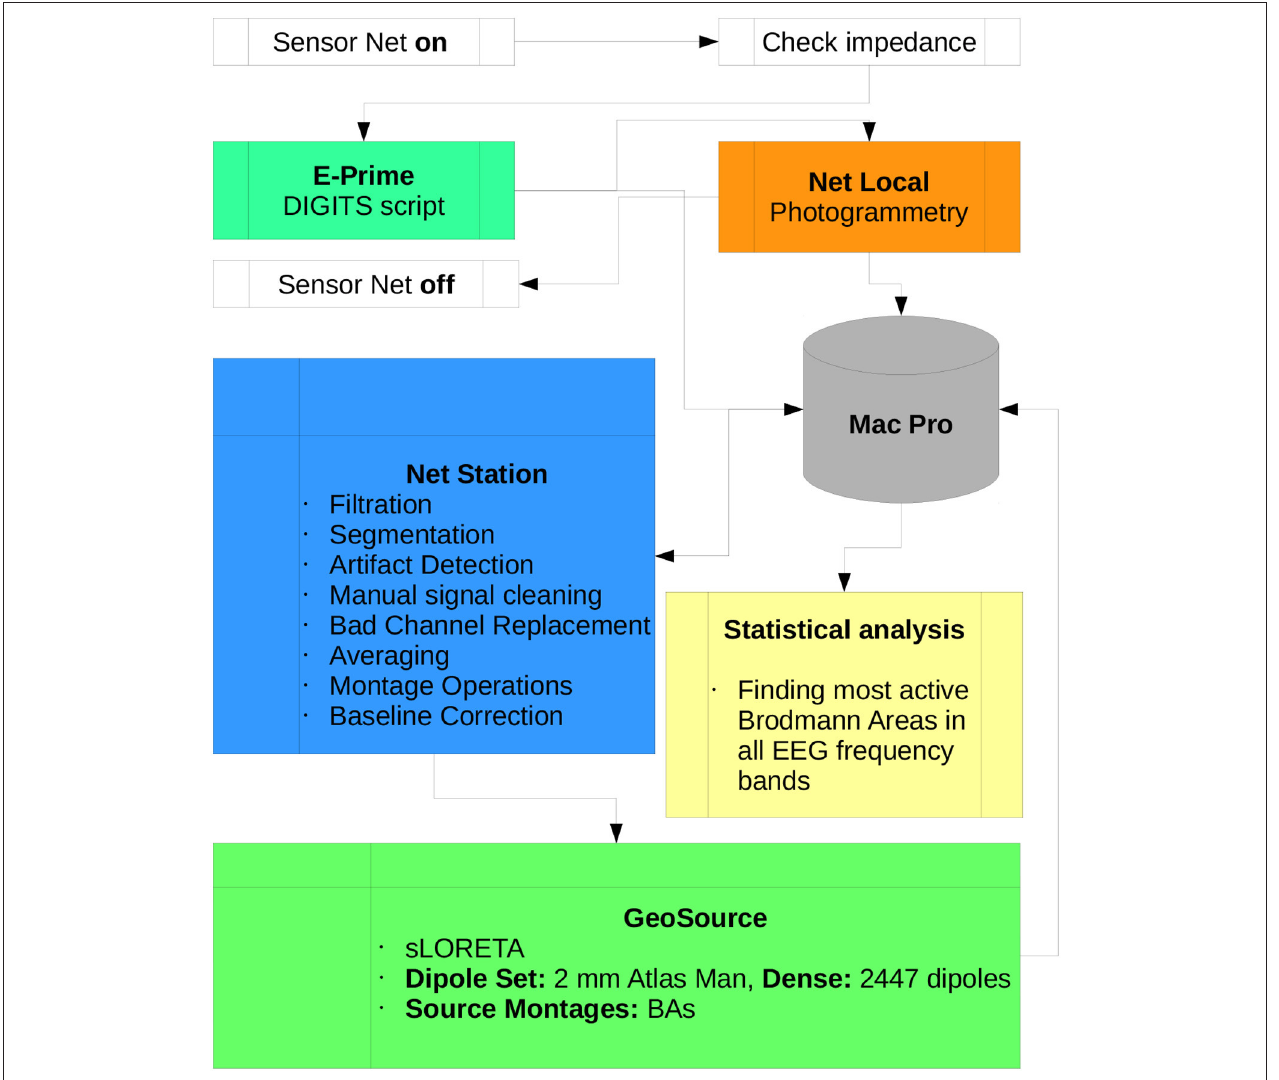
FIGURE 4 | Diagram of the DIGITS research protocol proposed in this paper. All scripts used for preprocessing data in Net Station and postprocessing in GeoSource are listed. Participation of the subject in the experiment begins when the Sensor Net is put on and ends when it is taken off. All data is collected by the Mac Pro workstation which is the central part of the lab. Statistical analysis, finding the most active BAs in each of α , β , γ , δ , and θ frequency bands can be conducted on other